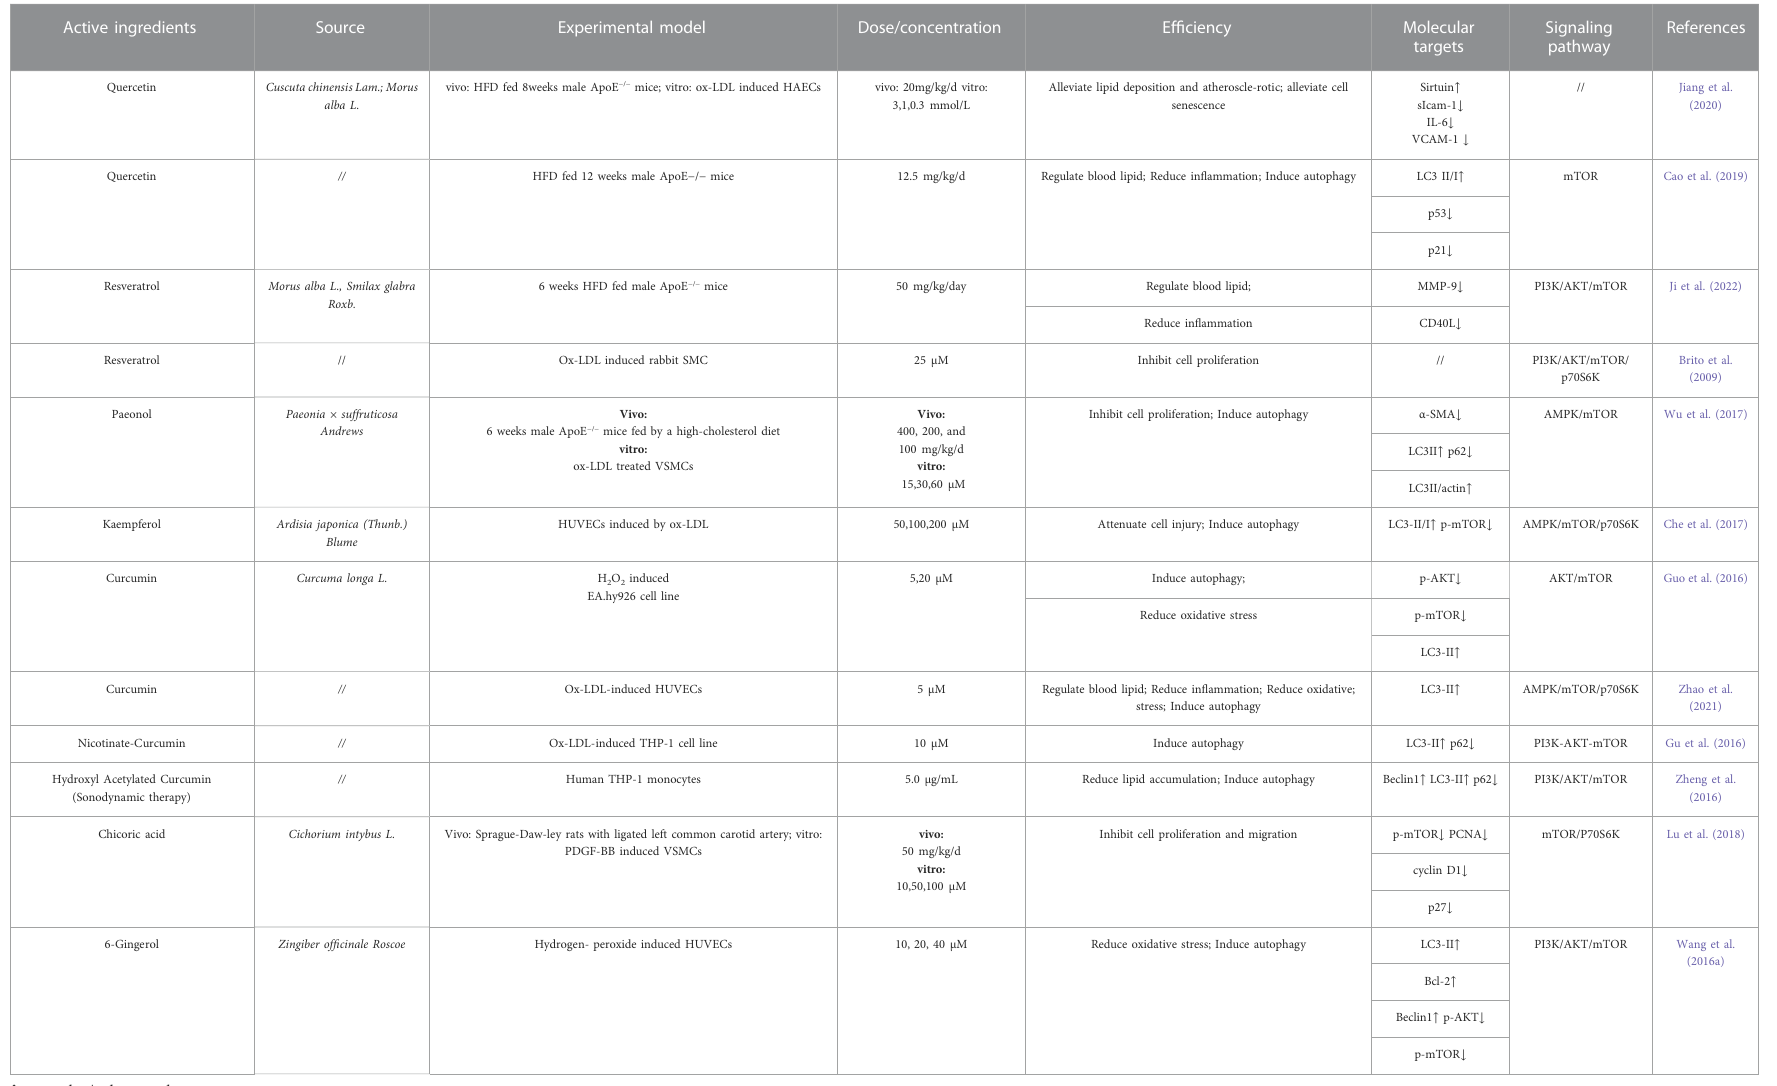
TABLE 1 Summary of the effects of polyphenolic natural compounds on different models of